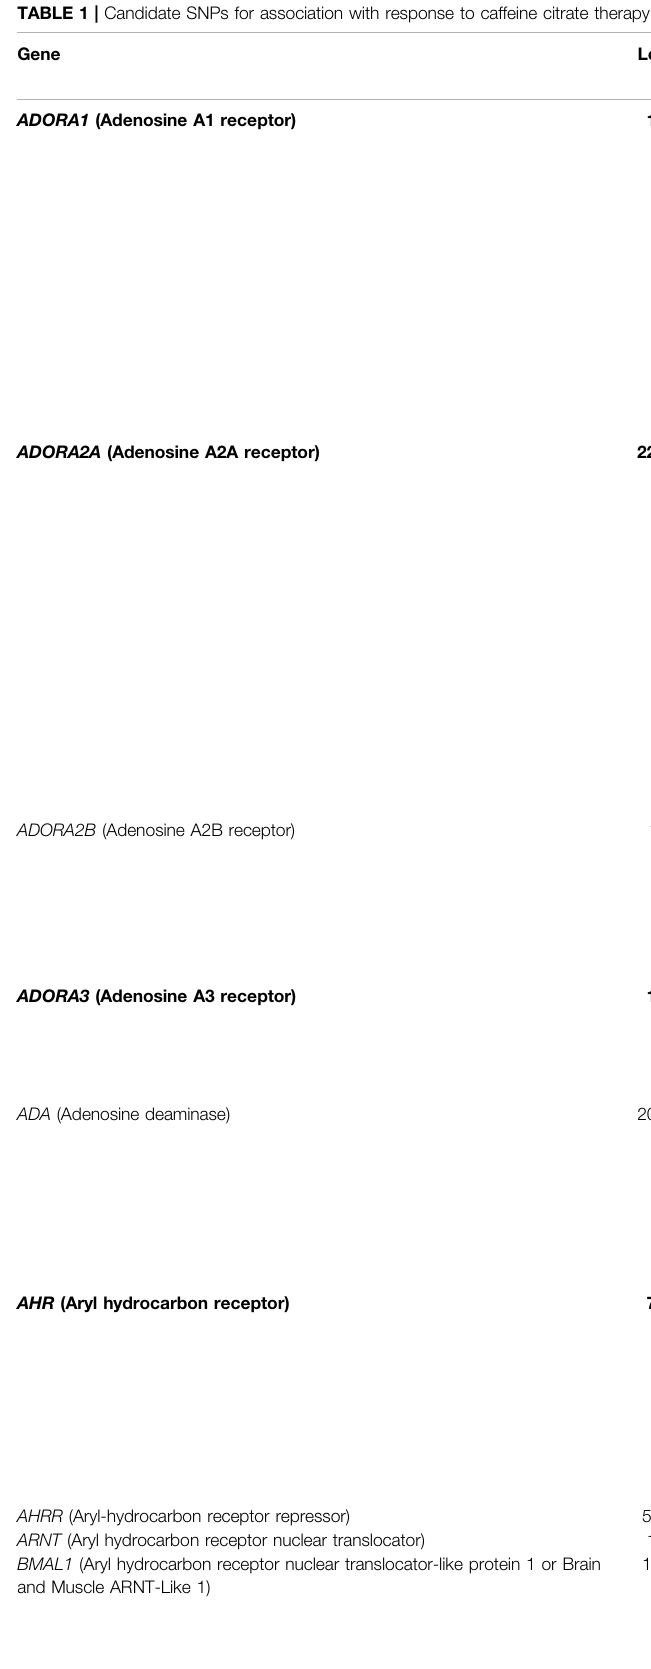
TABLE 1 | Candidate SNPs for association with response to caffeine citrate therapy for AOP. Gene Location SNP Alleles MAF Call ADORA1 (Adenosine A1